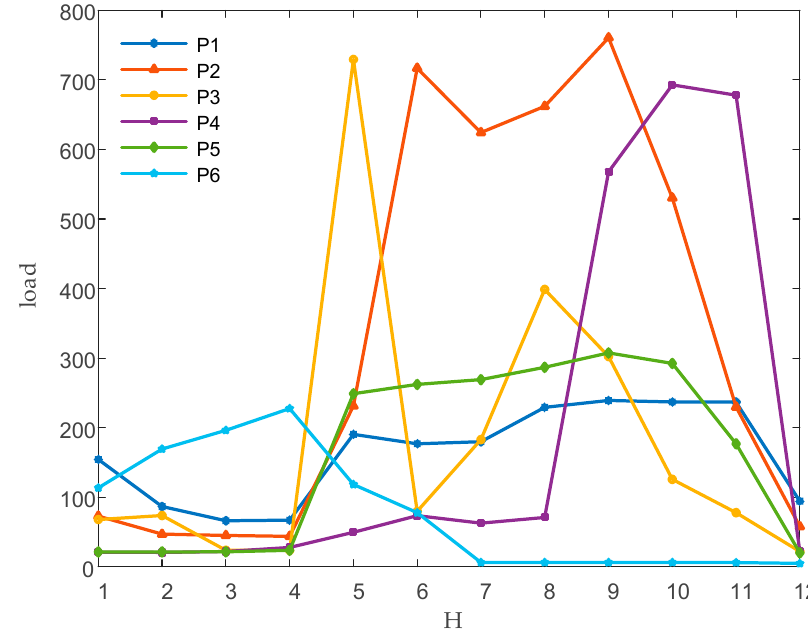
Figure 9. The original load profiles of multiple prosumers.